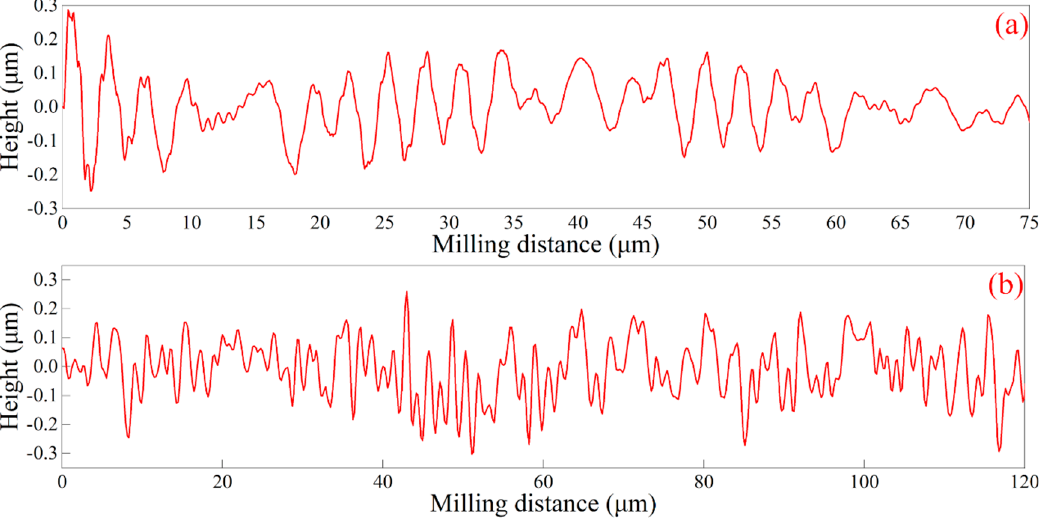
Figure 7. Groove bottom profile by the ( a ) FE simulation and ( b ) experiment of diamond micro- milling of the Cu workpiece.